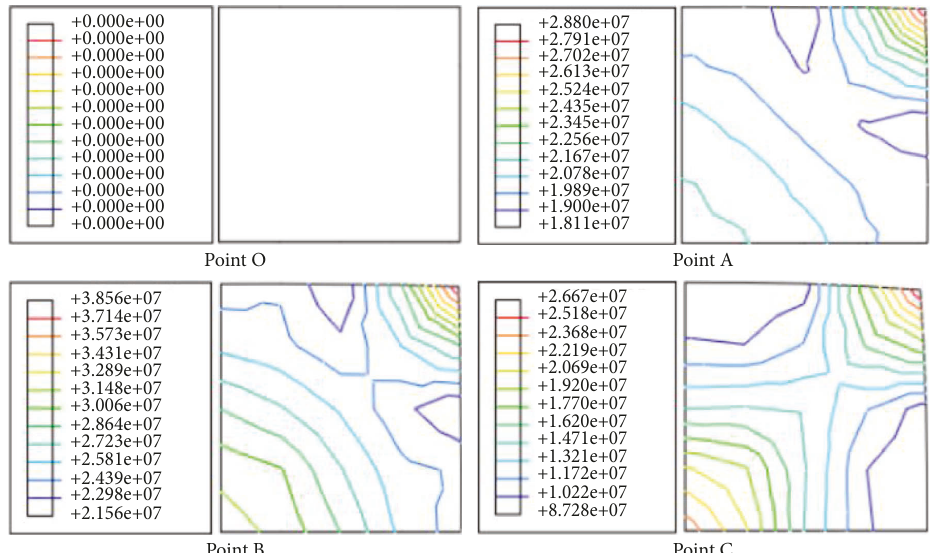
Figure 12: Stress distribution map of concrete midspan